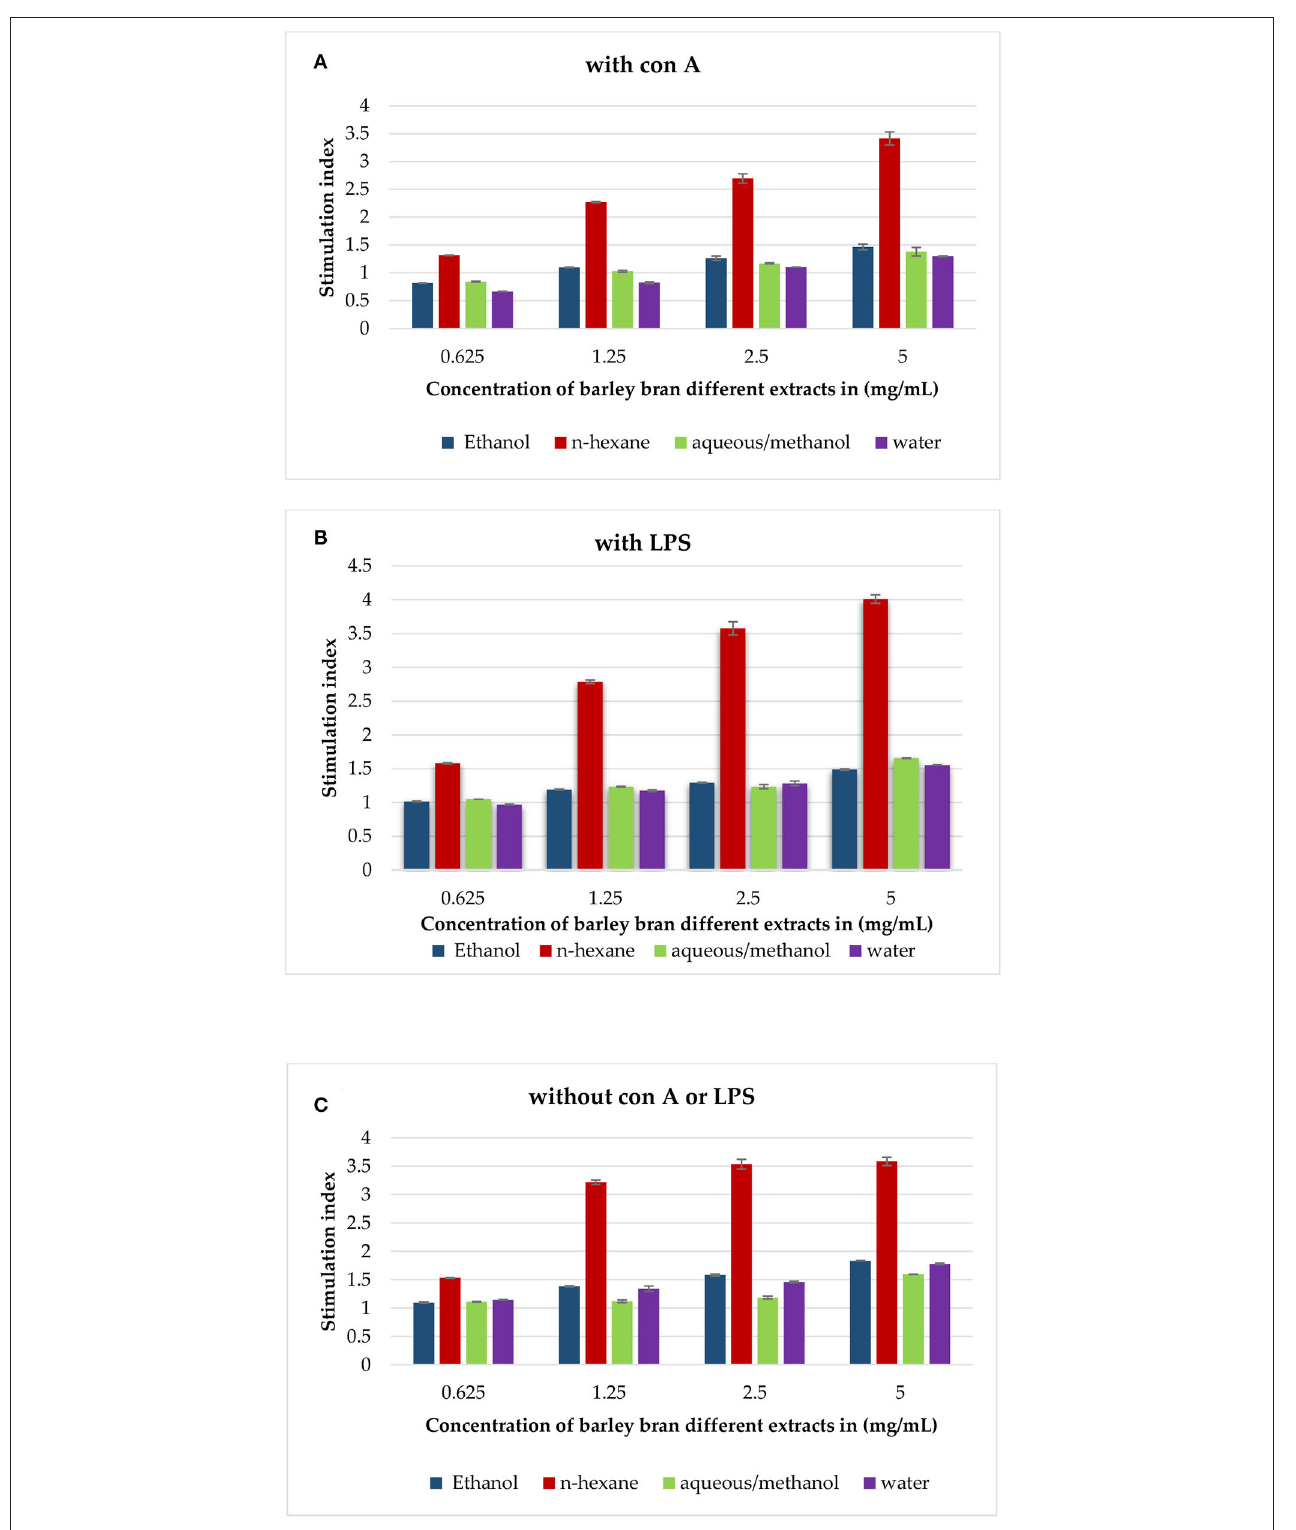
FIGURE 3 | (A) The effect of barley bran different extracts at different concentrations on the proliferation of splenic lymphocytes in the presence of Con A (5 µ g/ml). (B) The effect of barley bran different extracts at different concentrations on the proliferation of splenic lymphocytes in the presence of LPS (4 µ g/ml). (C) The effect of barley bran different extracts at different concentrations on the proliferation of splenic lymphocytes.